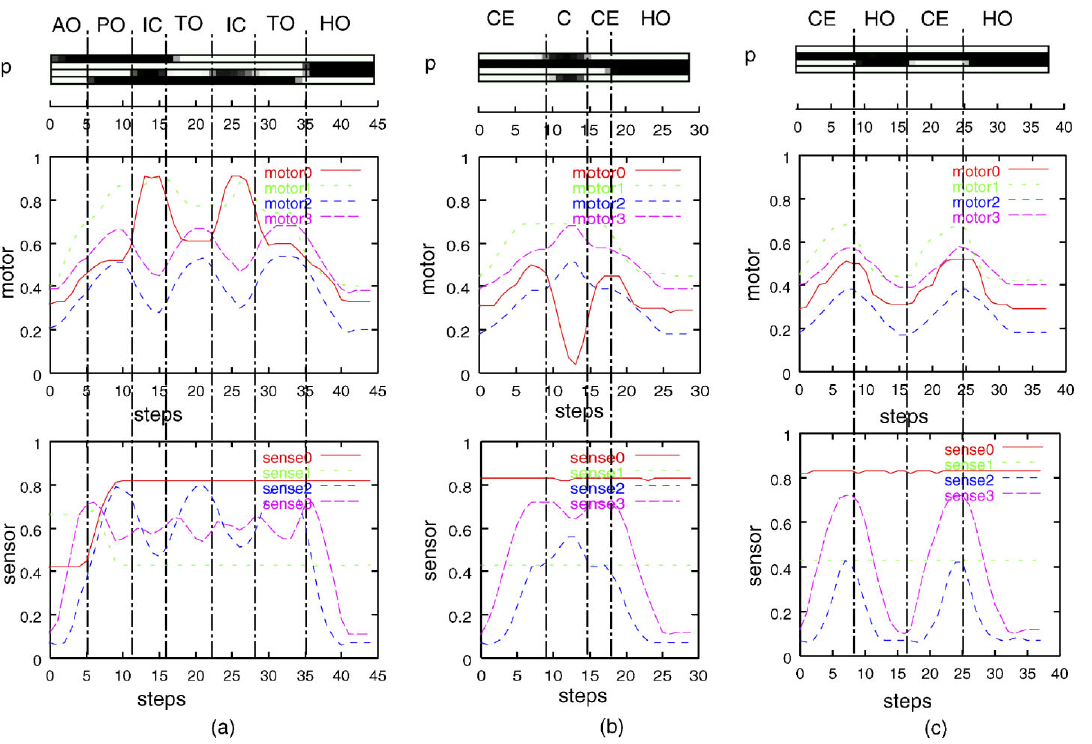
Figure 7. For the three representative training sequences (a)–(c), the temporal profiles of the parametric bias, the motor outputs are plotted in the second row and the sensor inputs are plotted in the third row . The vertical dotted lines denote occurrence of segmentation when the primitive behaviors switched. The capital letters associated with each segment denote the abbreviation of the corresponding primitive